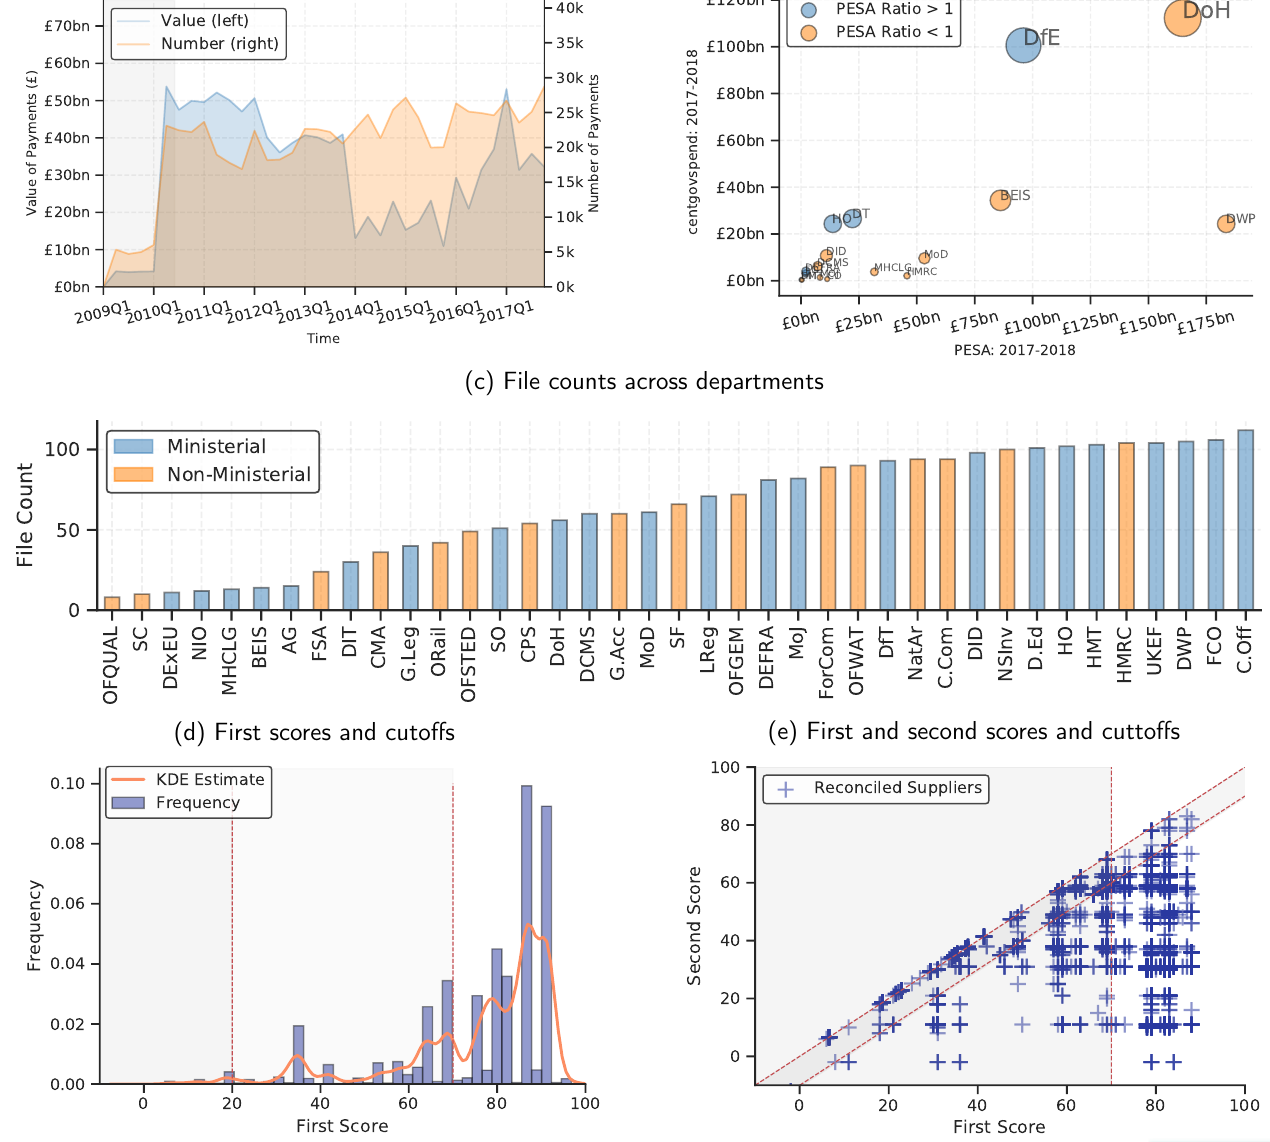
Figure Notes: Figure 3a details the coverage of centgovspend over time, with the gray shaded area indicating a time before the implementation of transparency requirements. Figure 3b visualizes government allocations from PESA (financial year 2017-2018), matched with data collected by centgovspend . Figure 3c is a simple count of files parsed by centgovspend . Figure 3d shows the distribution of the highest scores returned from the OpenCorporates reconciliation API. Figure 3e shows a scatter of the first and second highest scores for each unique